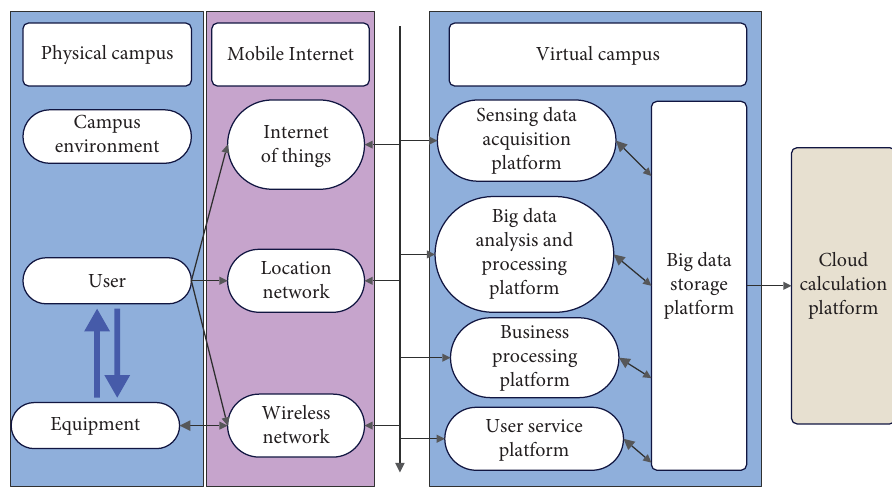
Figure 4: Schematic diagram of smart campus space